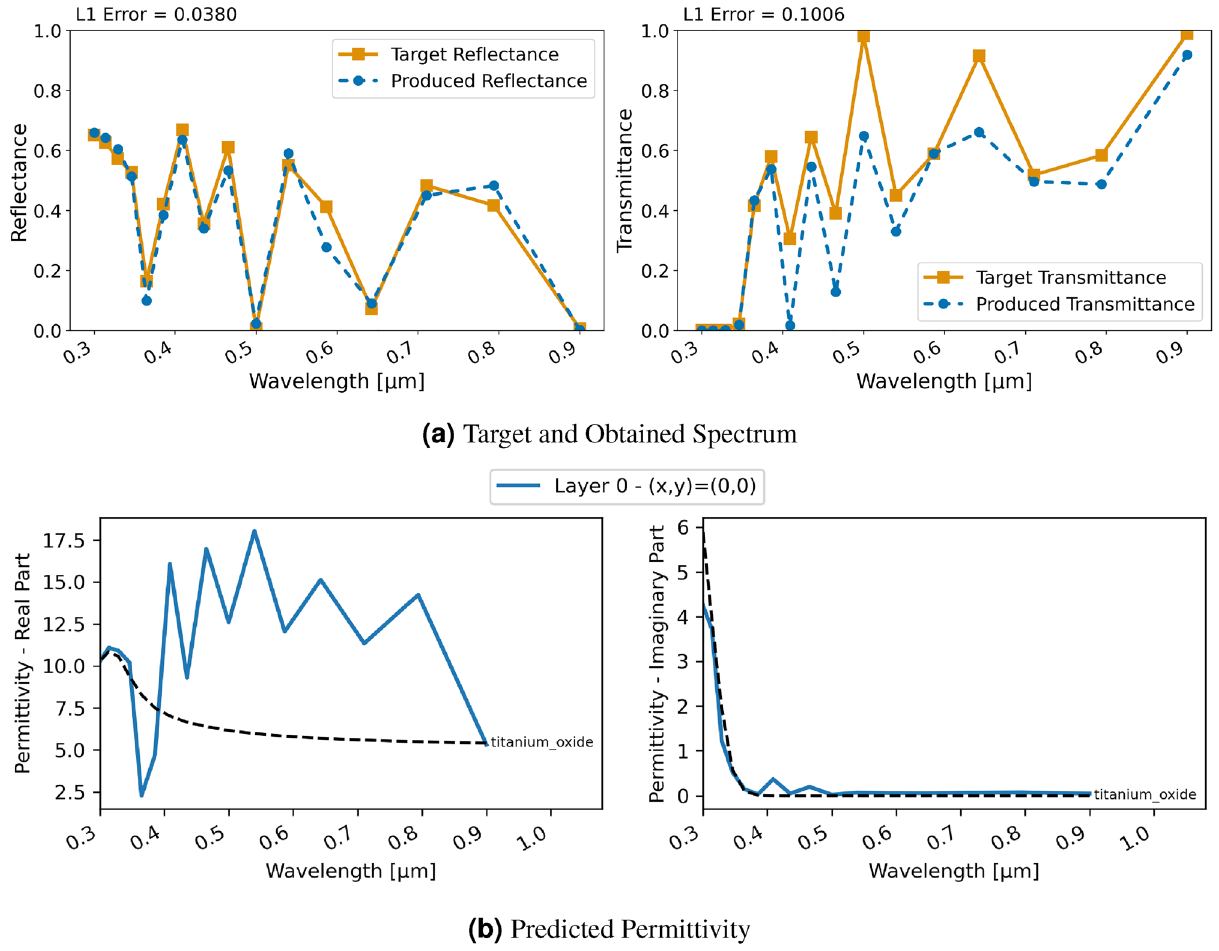
Figure 3. Inversion results for a single-layer TiO 2 material using FDTD and regression; ( a ) displays target and produced spectra, ( b ) shows the utilized permittivity; differences to Fig. 2 are due to smaller number of discretization grid Three‑layer uniform material. The second example is the design of a three-layer material consisting of TiO 2 , Germanium ( Ge ) and Ta 2 O 5 . Figure 5 displays the regression results with RCWA for this material. The design of the spectral properties is successful and the reflectance is achieved flawlessly. A small difference is noticeable at the lower end of the spectrum for the transmittance. Similar as for the previous inversion with FDTD, however,